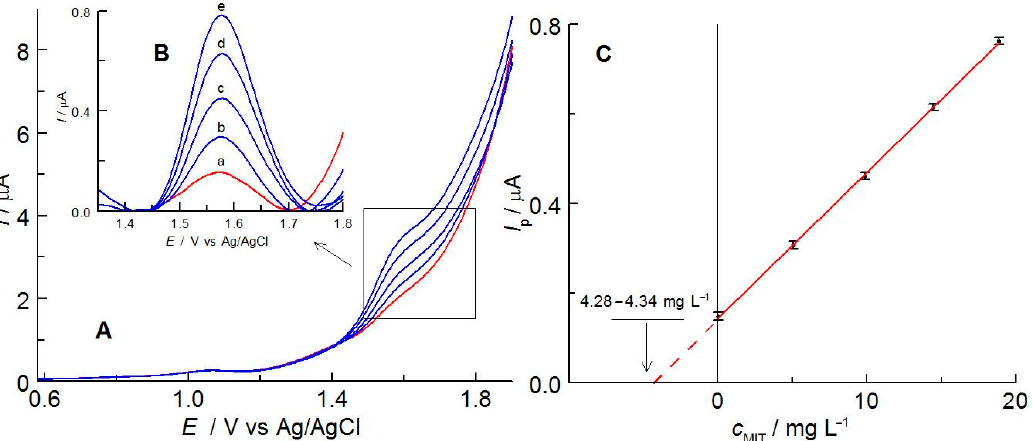
Figure 6. ( A ) DPVs recorded in a solution containing (a) Perwoll ( V 0 = 2.0 mL) and after addition of the MIT standard solution (207.4 mg L − 1 ) with the volume of: ( b ) 50 µL, ( c ) 100 µL, ( d ) 150 µL, ( e ) 200 µL. ( B ) DPV curves from ( A ) after subtracting the background current. ( C ) Calibration plots for five determinations in the standard addition method.